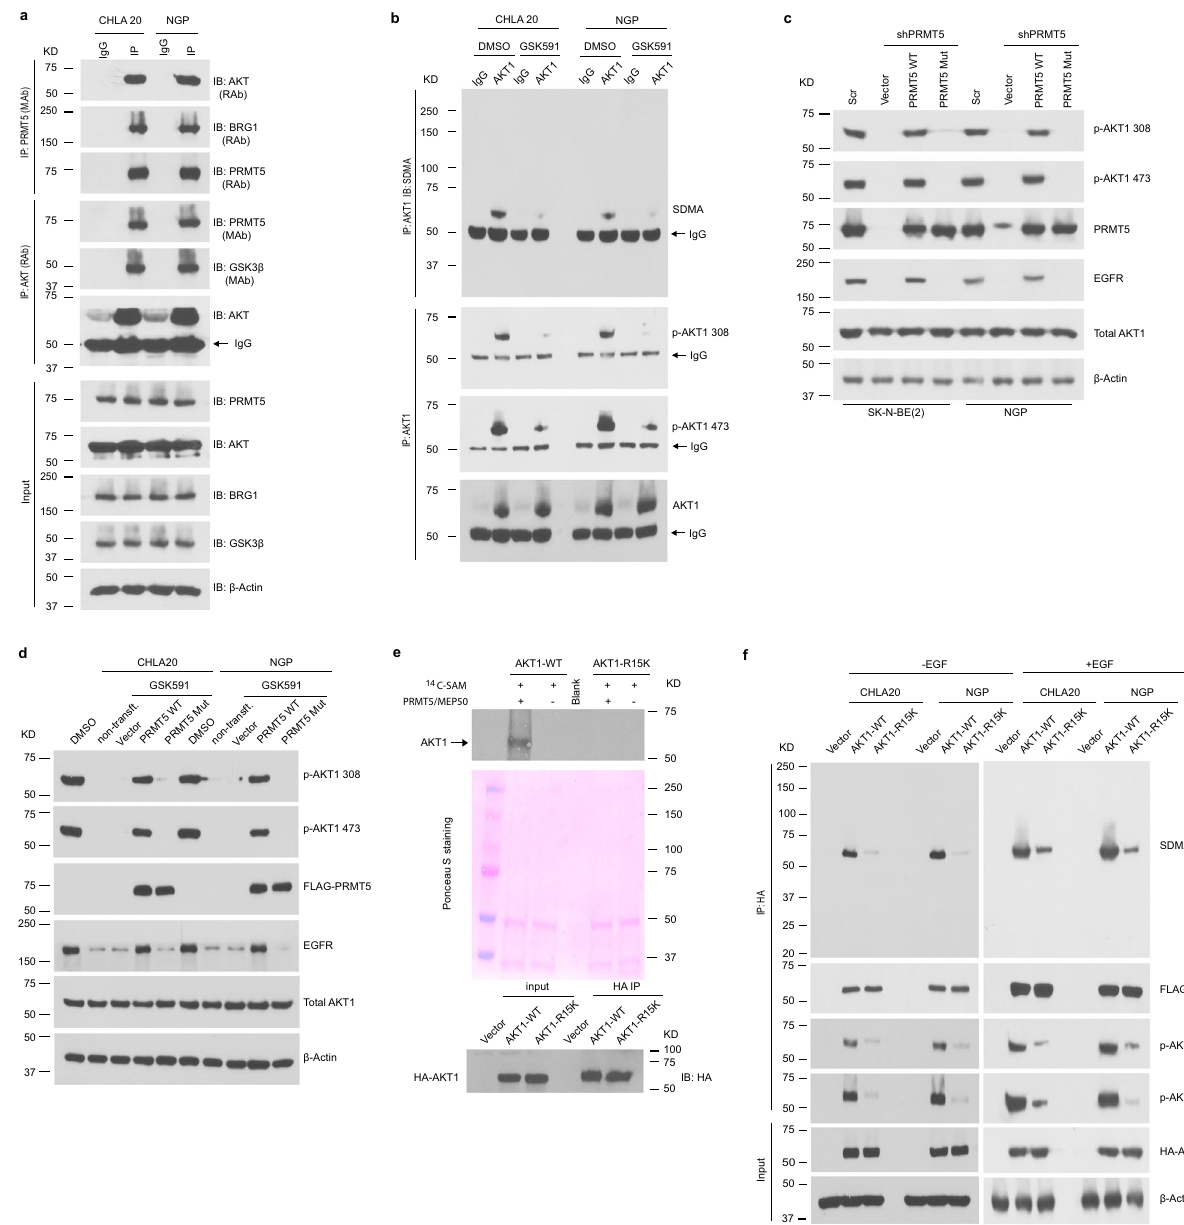
Fig. 4 PRMT5 methylates AKT. a PRMT5/AKT interaction captured by co-immunoprecipitation (co-IP). The lysate was immunoprecipitated with anti- PRMT5 antibody followed by immunoblotting with anti-AKT antibody in CHLA20 and NGP cells (top), and the reciprocal co-immunoprecipitation was shown in the middle. BRG1 and bait protein PRMT5 were shown as positive controls for the PRMT5 IP, whereas GSK3 β and bait protein AKT served as positive controls for AKT IP. The input was used as internal controls (bottom). b Immunoprecipitation of AKT1 followed by a Western blotting analysis of symmetric dimethylarginine (SDMA) of AKT1, phosphorylation of AKT1 on Thr308 and Ser473 in DMSO or GSK591-treated CHLA20 and NGP cells. c AKT1 phosphorylation was detected by immunoblotting in a scramble or PRMT5 knockdown cells when forced expressing a wild-type PRMT5 or an enzymatic de fi cient form of PRMT5. d Analysis of AKT1 phosphorylation in DMSO or GSK591-treated CHLA20 and NGP cells expressing PRMT5 wild type or enzyme dead mutant. e In vitro methylation assay showing the methylation of AKT1 wild type and R15K mutant by recombinant PRMT5/MEP50 (top), Ponceau S staining of the membrane showing equal loading of each sample (middle), and Western blotting analysis showing an equal amount of HA- tagged proteins pulled down by anti-HA beads (bottom). f Analysis of SDMA and phosphorylation of AKT1 wild type or R15K mutant in CHLA20 and NGP cells with (right) or without (left) EGF stimulation. Cells were transfected with AKT1 wild type or R15K mutant. In the case of EGF stimulation, 24 h post- transfection, cells were serum-starved overnight and then treated with 10 ng/mL EGF for 15 min before harvest. a – d , f Representative results from three independent experiments. e Representative results from two independent biological samples. Uncropped immunoblots are provided in the Source Data fi le.